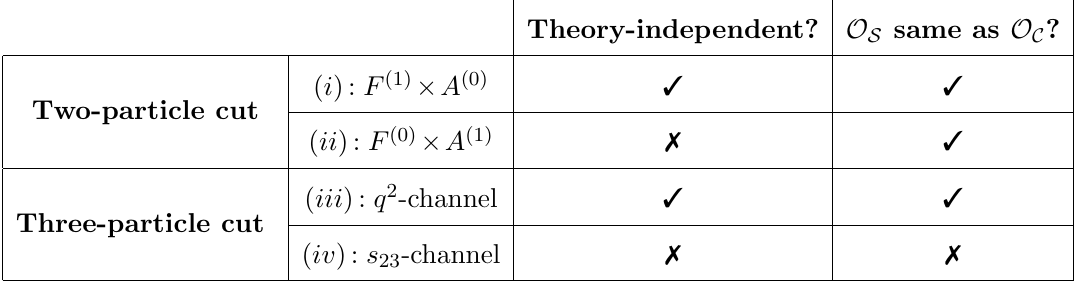
(1 + ; 2 + ; 3 + ; q ). O S ; O C